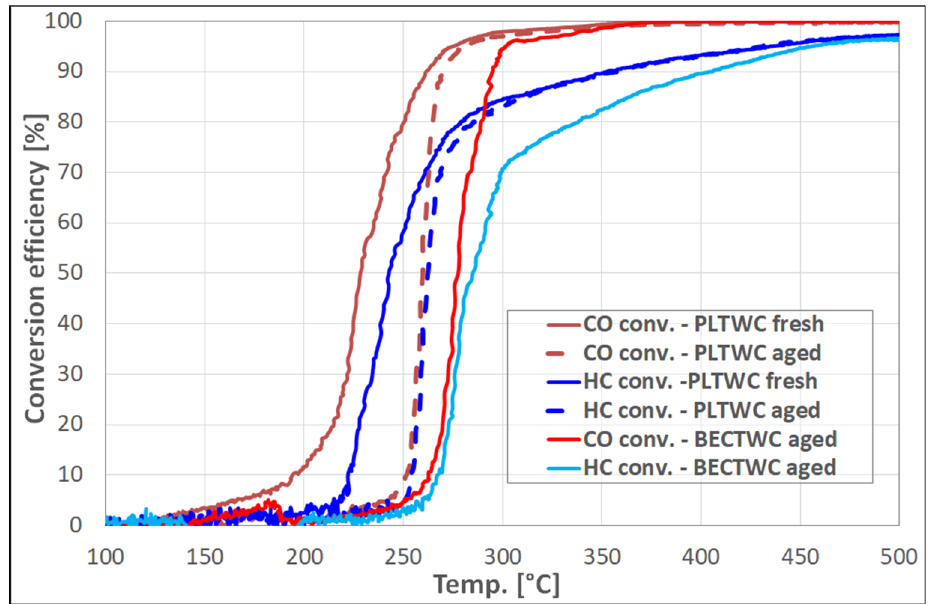
Figure 5. TWC light-off test: CO/HC conversion efficiencies (test in LEAN conditions). To evaluate the ability of the catalysts for the reduction of NO x , the gas mixture needed to be slightly rich ( λ < 1). The results of the NO x conversion efficiency are presented in Figure 6. The PLTWC fresh catalyst was found to be active at temperatures above 200 °C, while the aged PLTWC and BECTWC catalysts presented activity at slightly higher temperatures (above ~240 °C). Again, the activity of the catalysts for NO x reduction was found to follow the same order observed for the CO and HC oxidation reactions. It should be noted that the samples obtained from recycled PGMs presented full conversion efficiency behavior. On the other hand, benchmark catalysts have shown slightly poorer performances (maximum NO conversion of ~95%).